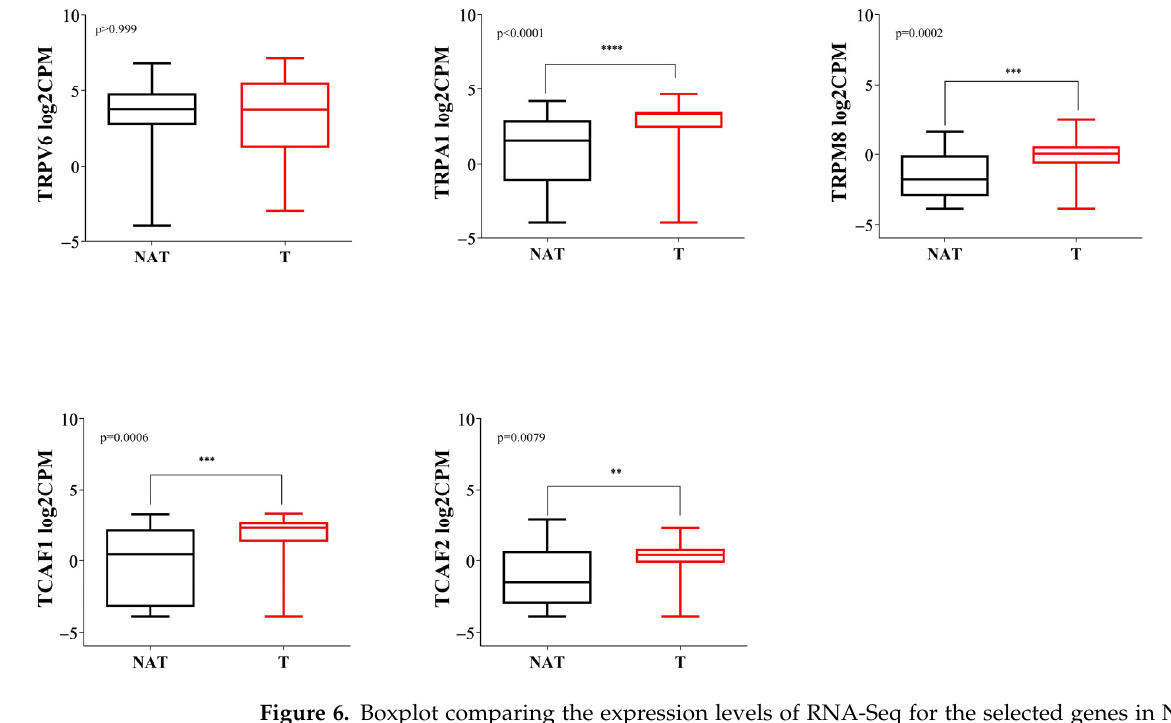
Figure 6. Boxplot comparing the expression levels of RNA-Seq for the selected genes in NAT vs. tumoral tissues from resected PDAC patients. The validation cohort consisted of 68 tissue samples from 36 patients (** p < 0.01, *** p < 0.001, **** p < 0.0001).